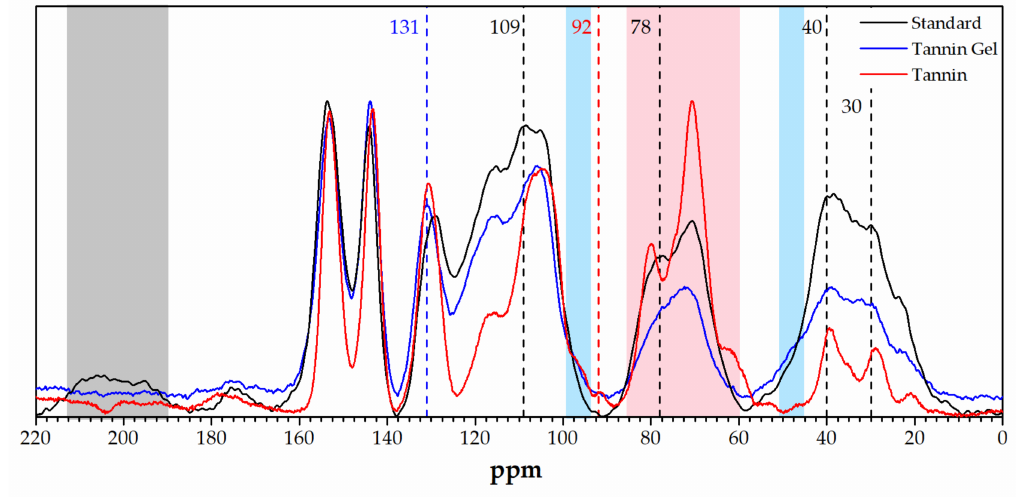
Figure 4. Solid-state 13 C-NMR spectra of the standard foam (black), the tannin acidified gel (blue), and the tannin extract